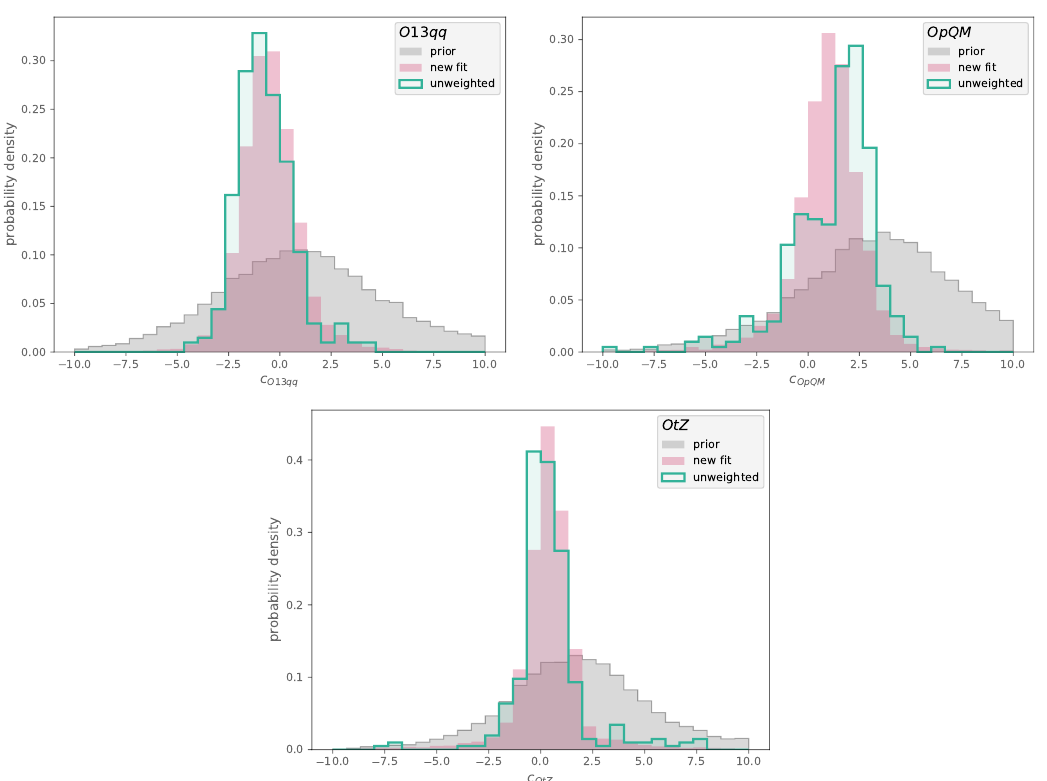
Figure 3.4: The probability distribution associated to the Wilson coefficients c 13 c . The prior results are compared to the results obtained by reweighting and unweighting tZ the prior with the t -channel single-top production cross sections and from a new fit to the extended